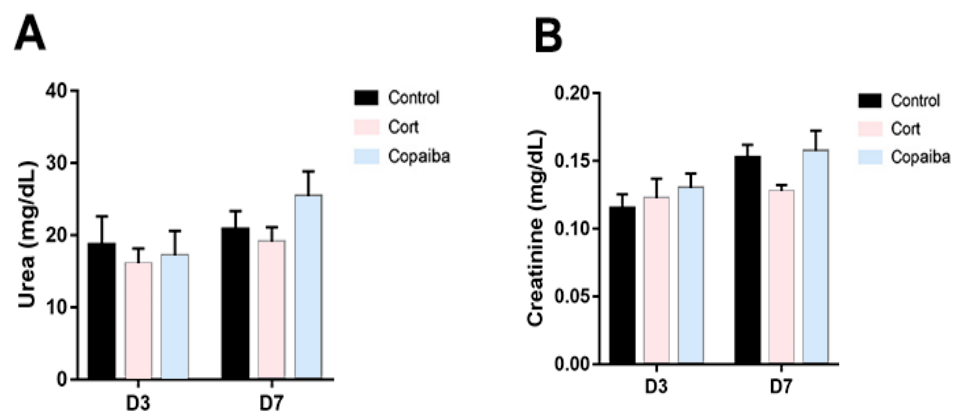
Figure 5. Levels of renal function parameters in different groups. ( a ) No significant differences between the groups were found in the levels of urea and ( b ) creatinine in plasma at D3 ( n = 15) and D7 ( n = 15), suggesting that the dosage of both copaiba and corticoid administered was harmless for the kidneys. The results are expressed as the mean ± standard error of the mean. One-way ANOVA and Tukey’s post hoc tests.